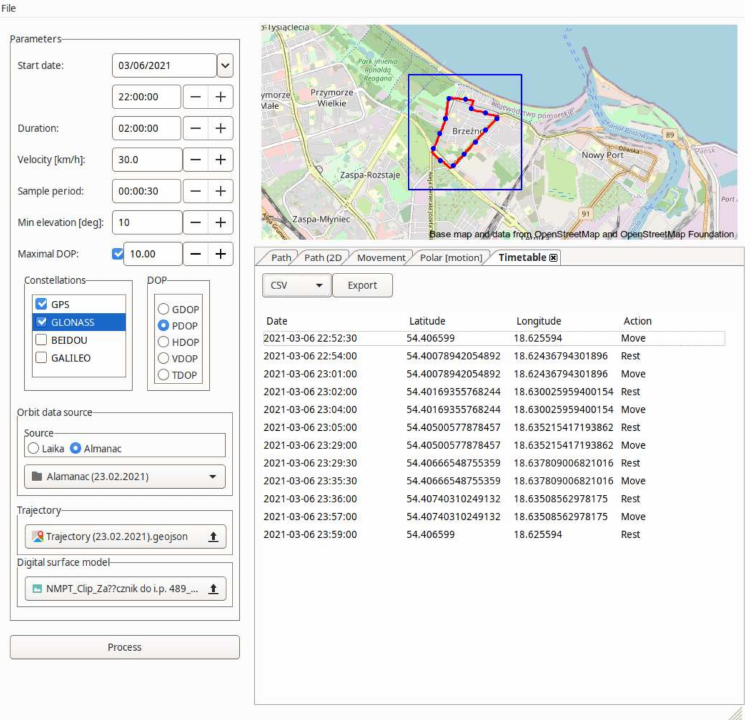
Figure 10. Window of the software for the planning of a linear object GNSS measurement campaign for the optimum variant during the performance of the first test